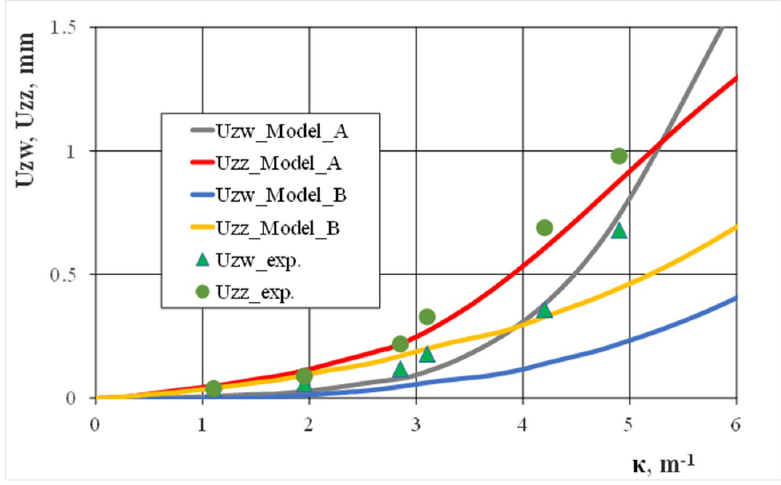
Figure 9. The e ff ect of bending curvature when deflecting the horizontal walls of the 25 × 25 × 2 square steel pipe.